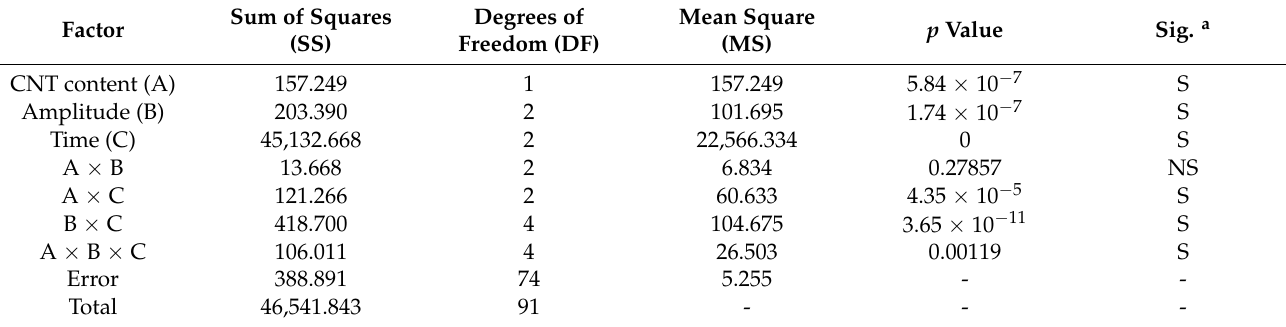
Figure 10. Compressive strength at 1, 7 and 28 days of the cementitious composites. Table 6. Three-way ANOVA of compressive strength results.